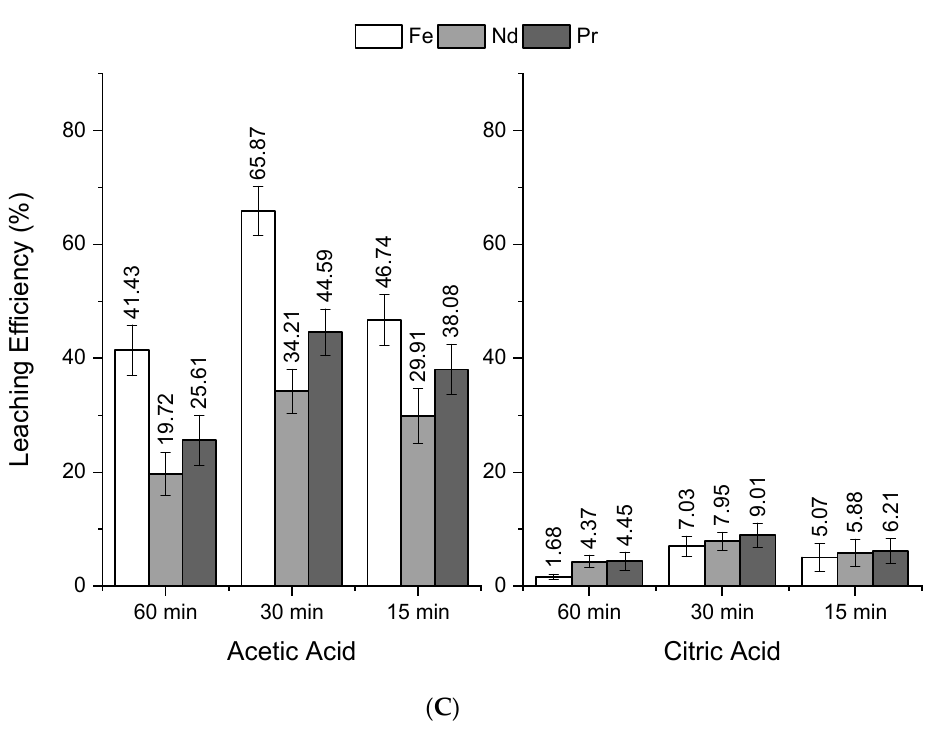
Figure 4. Comparison of the leaching efficiency of NdFeB magnets in acetic and citric acids, concen- tration 0.5 M, ratio s/l ( A ) 1/100; ( B ) 1/50 and ( C ) 1/10.